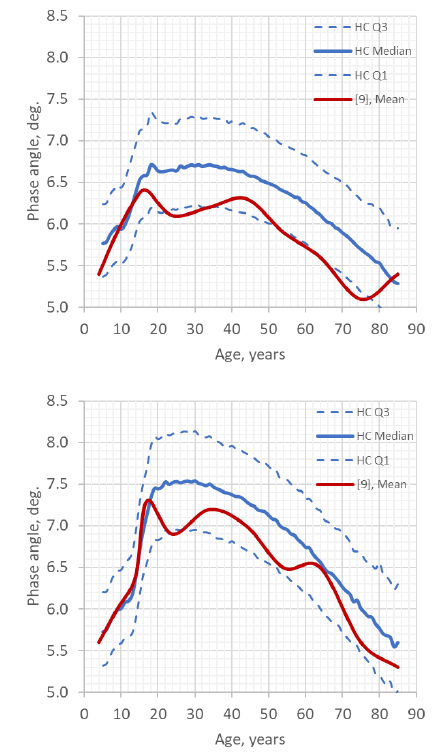
Fig.7: HCs’ reference data on the phase angle at 50 kHz according to age: the medians and interquartile range (blue lines). Upper panel – females (n=1,607,906), lower panel – males (n=822,071). The red lines show estimated mean values according to meta-analysis of pooled data from 46 studies